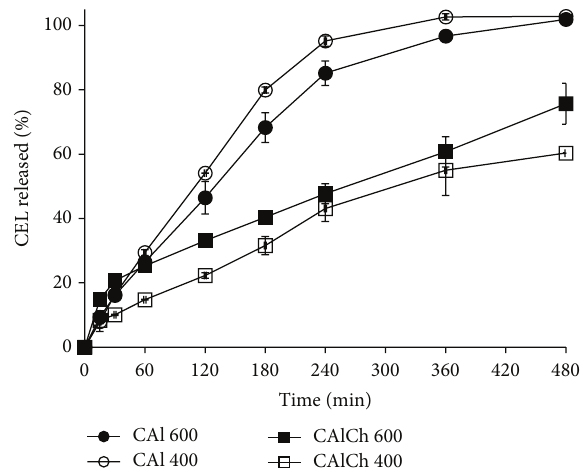
Figure 7: Celecoxib release profiles in phosphate buffer at pH 6.8.